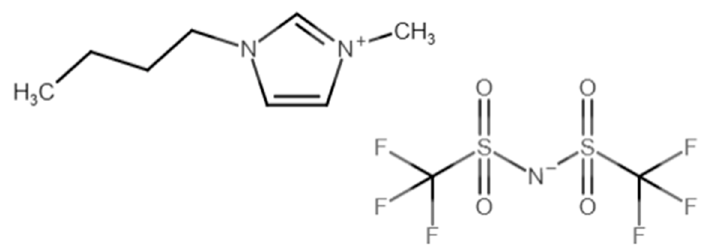
Figure 9. Chemical structure of 1-butyl-3-methylimidazolium bis((trifluoromethyl)sulfonyl)imide. Table 4. Estimation of the melting point of ILs using GCM1 and GCM2 with 1-butyl-3-methylim- idazolium bis((trifluoromethyl)sulfonyl)imide as an illustration of the general procedure.